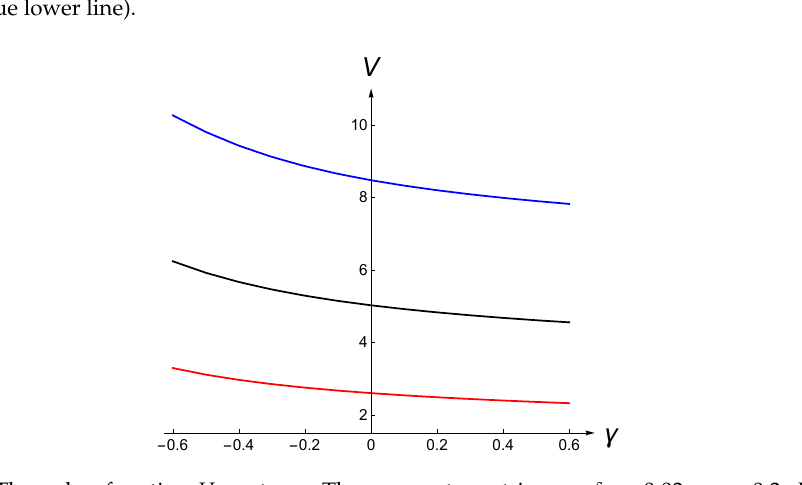
Figure 3. The value function V w.r.t. γ . The parameter set is r = δ = 0.03, σ = 0.3, K 1 = 10, K 2 = K 1 ( 1 + γ ) , γ ∈ ( − 0.6,0.6 ) , λ = 0.2. We plot the value function for X 0 = 6 (red line), X 0 = 10 (black line), X 0 = 15 (blue line).